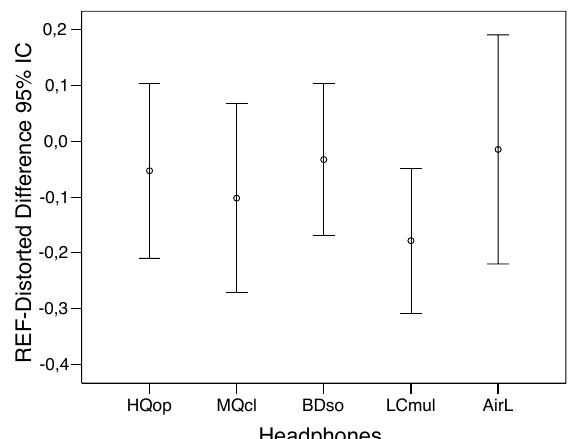
Figure 8. Difference between hidden reference and distorted signals versus